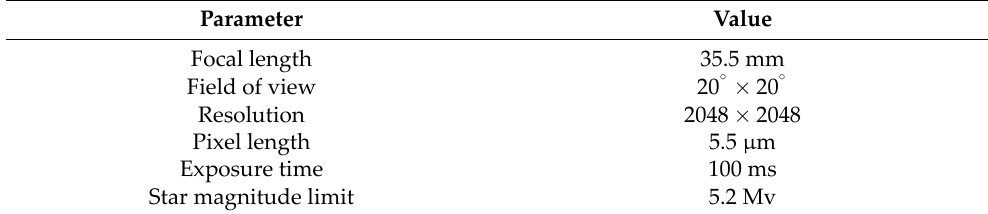
Table 3. Parameters of star tracker.